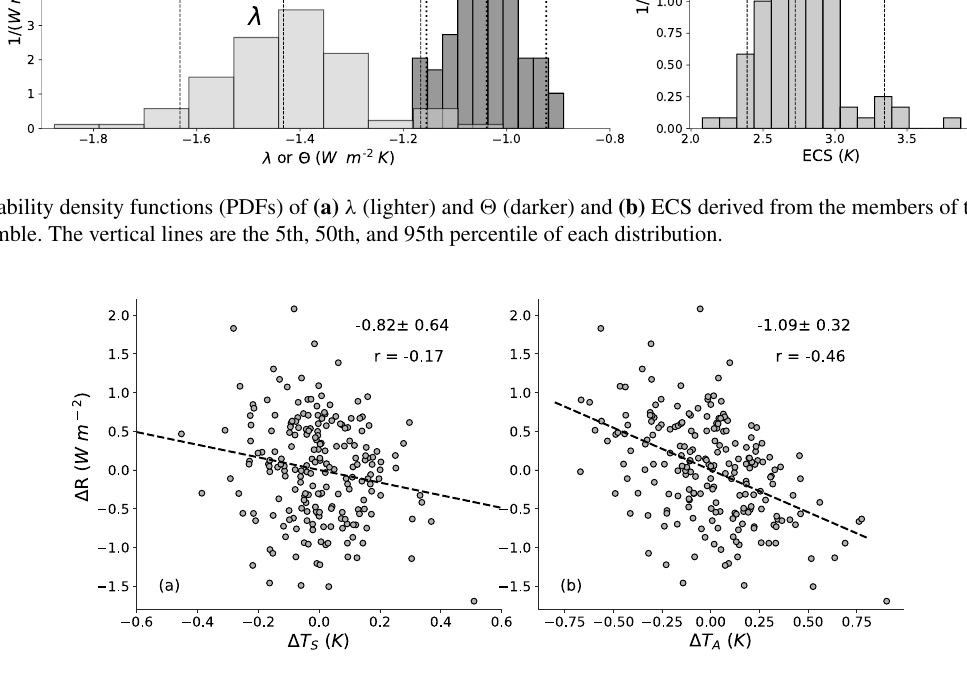
Figure 3. Scatterplot of monthly anomalies of (cid:49)R vs. (a) global average surface temperature (cid:49)T S and (b) tropical average 500hPa tem- perature (cid:49)T A . Observations cover the period March 2000–July 2017, and anomalies are deviations from the mean annual cycle. (cid:49)R and temperature time series are detrended to account for forcing. The dashed lines are ordinary least-squares fits; the slope, 5–95% confidence interval, and correlation coefficient are shown on each panel. Confidence intervals account for autocorrelation of the time series (Santer et al.,